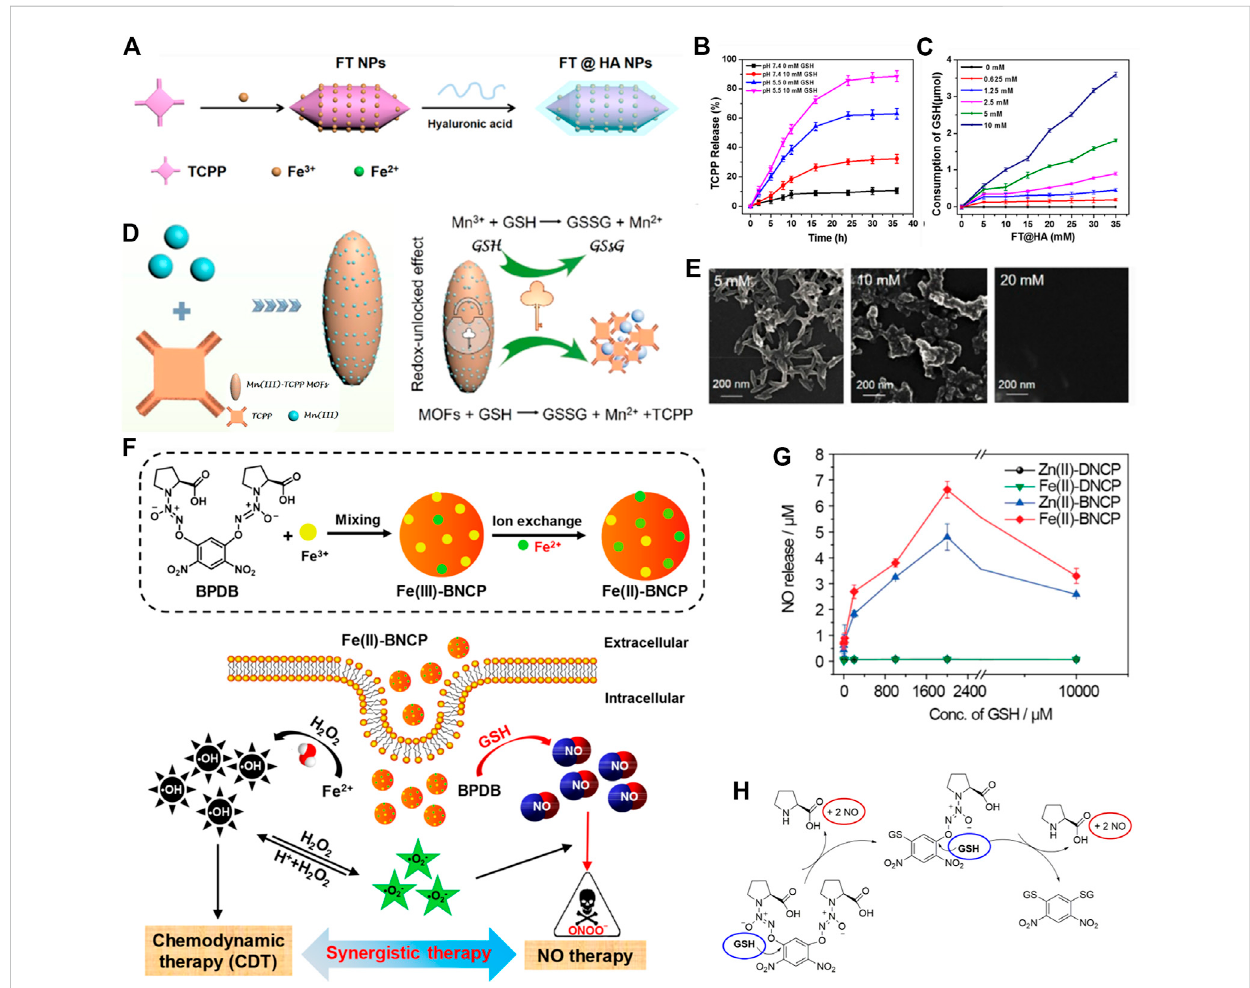
FIGURE 2 (A) Schematic illustration of FT@HA synthesis. (B) The pH and GSH-responsive TCPP release. (C) Detection of GSH consumption. Reproduced with permission. Copyright 2020 American Chemical Society. (D) The scheme of Mn 3+ -TCPP MOFs preparation and mechanism for redox-unlocked therapy. (E) Scanning electron microscope images of Mn 3+ -TCPP MOFs with various concentrations of GSH. Reproduced with permission. Copyright 2019 American Chemical Society. (F) Schematic illustrationofFe(II)-BNCPpreparation andNO-CDTsynergistic therapy. (G) NOrelease from Fe(II)- BNCP at various levels of GSH. (H) The mechanism of NO release from Fe(II)-BNCP in high levels of GSH. Reproduced with permission. Copyright 2019 American Chemical